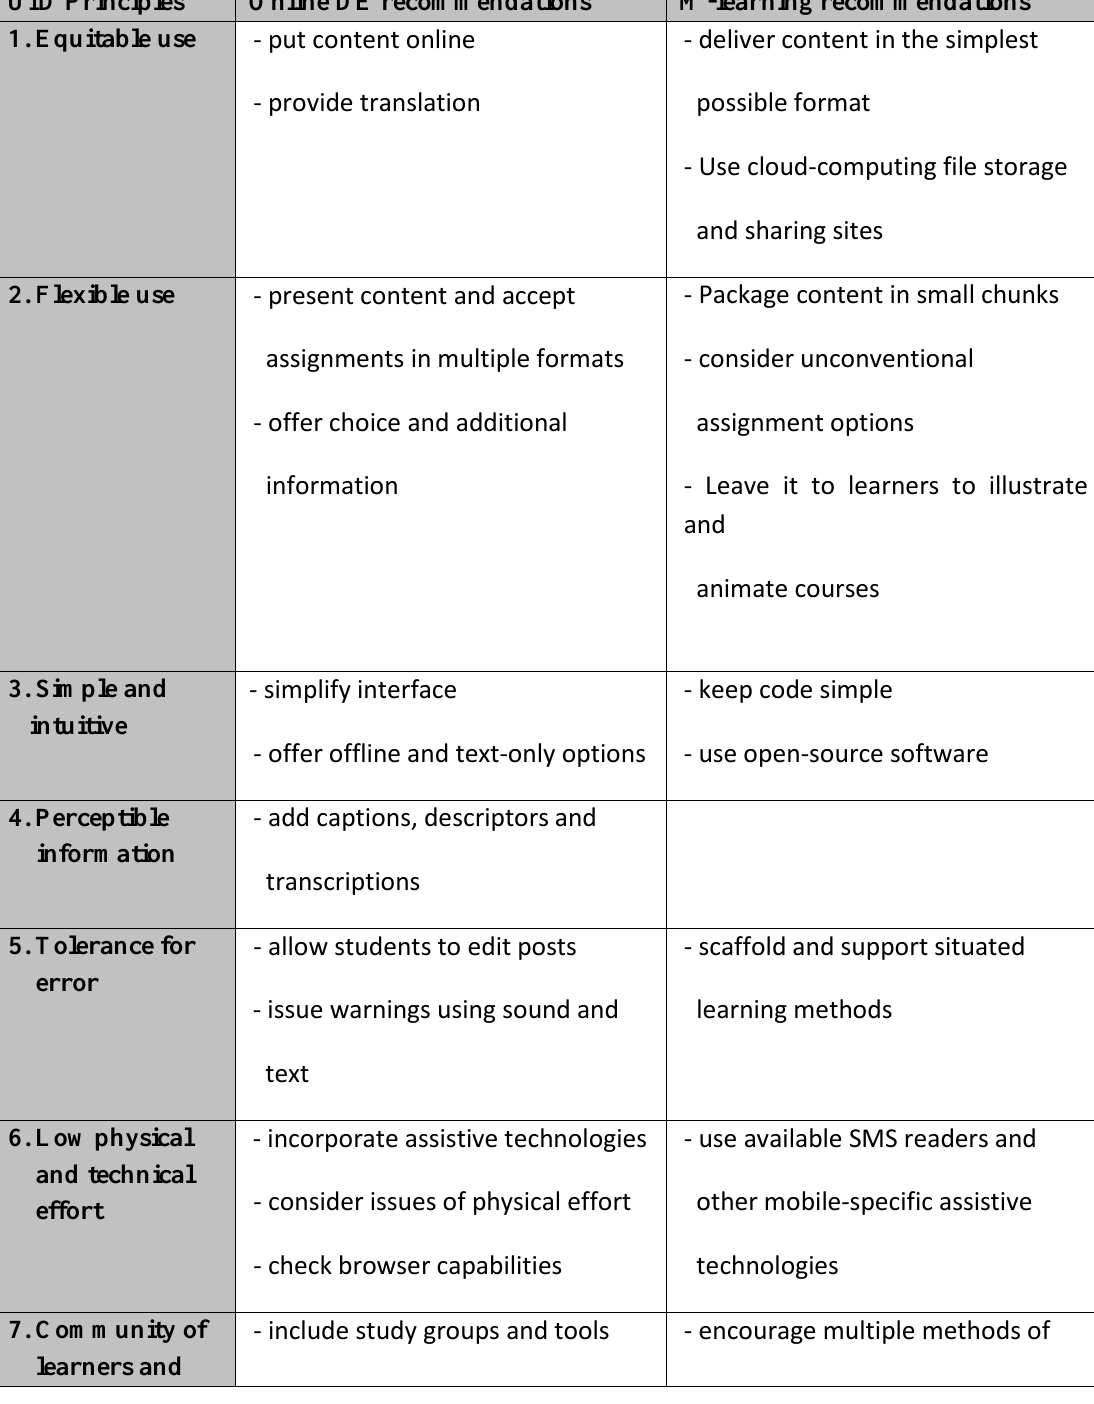
Table 1 UID Recommendations for Inclusive M-Learning UID